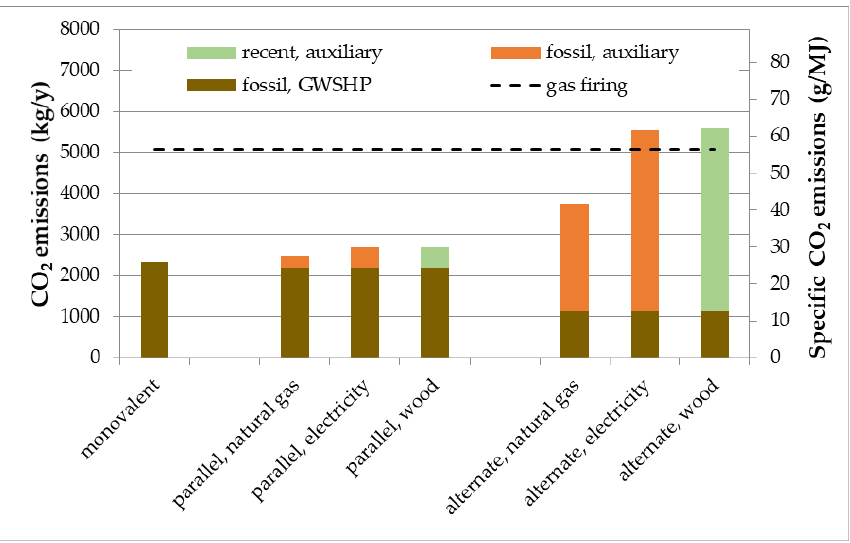
Figure 8. Annual CO 2 emissions of different bivalent GSHP systems. Table 5. CO 2 emissions reduction rates, GWSHP.